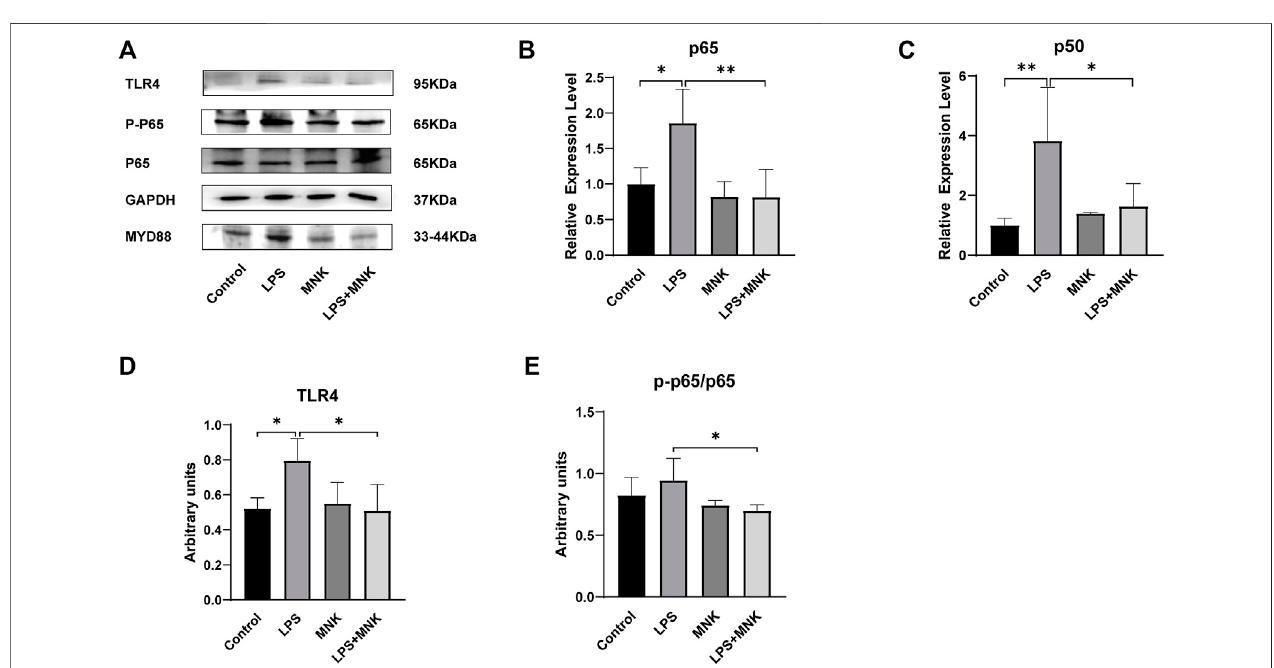
FIGURE6| Theeffectsof2-methylnonylketone(MNK,10 μ g/ml)onthelevelsofToll-likereceptor4-nuclearfactor- κ B(TLR4-NF- κ B)signalingpathwayinducedby lipopolysaccharide (LPS, 100 μ g/ml) in MAC-T cells. (A) The expression of the TLR4 signaling pathway was measured using Western blot. (B) p65 . (C) p50 . (D) TLR4. (E) p-p65/p65. GAPDH was used as an internal reference for Western blotting analysis. The data are shown as mean ± SD. N (cid:1) 3. *, p < 0.05; **, p < 0.01.